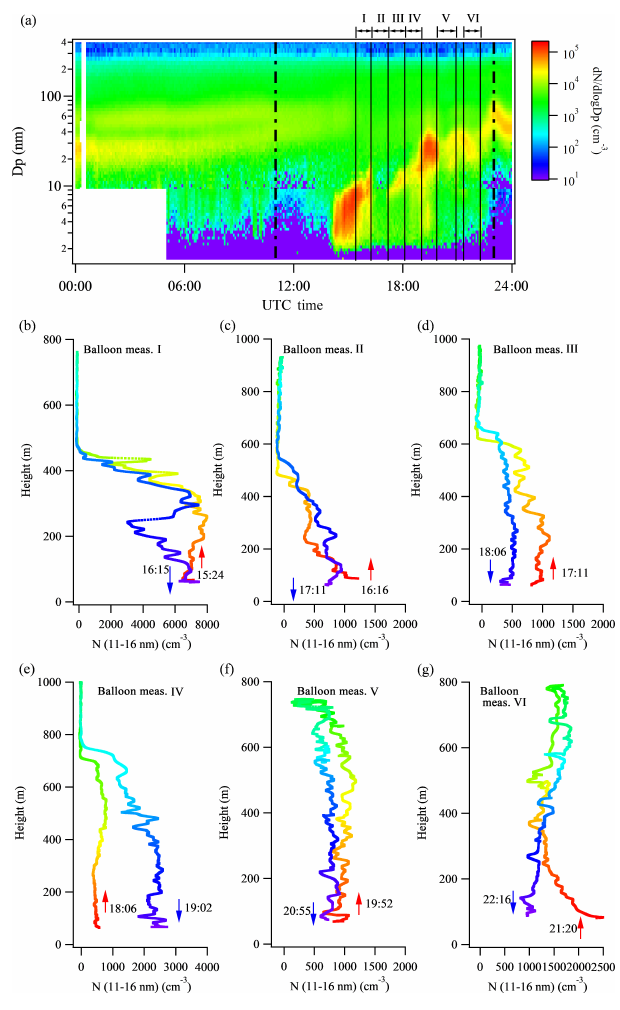
Figure 5. New particle formation event on 13 May 2013 at SGP. (a) Particle size distributions captured by ground-based scanning mobility particle sizers. The two vertical dashed lines represent 06:00 and 18:00 local time, respectively. The vertical black solid lines represent the time frame of the tethered balloon measurements. (b–g) Vertical profiles of particle number concentration in the size range of 11–16nm measured by the tethered balloon system. Six launches were made during the new particle formation event. A rainbow color pattern is used to illustrate the time after the balloon measurements were started, with red representing the initial period and purple representing the final period of a